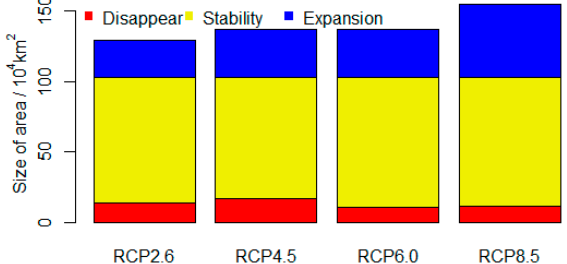
Figure 3. Potential loss, stable, and expanded ranges of climatically suitable areas for Chinese sea buckthorn under four climate change scenarios (2070s). The loss plus stable area is equal to the current distributional area. The stable plus expanded area is equal to future distributional area. The expanded minus loss area is equal to the area change between current and future climate conditions.